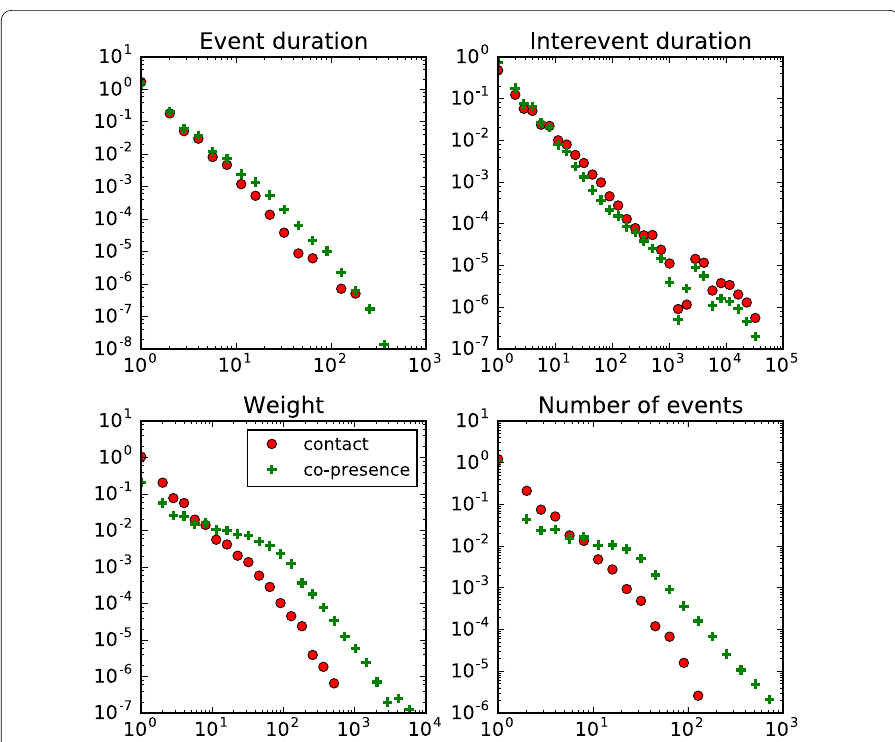
Figure 1 Temporal distributions for co-presence and contact events—InVS15. We show for both the contact and co-presence of the same data set the distributions of event and inter-event duration, link weights (as total contact duration) and number of contacts per